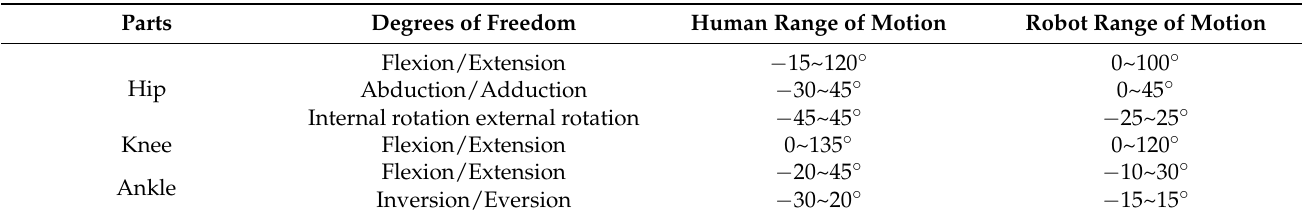
Figure 1. Fundamentals of human motion. Table 1. Degrees of freedom allocation of human lower-limbs and